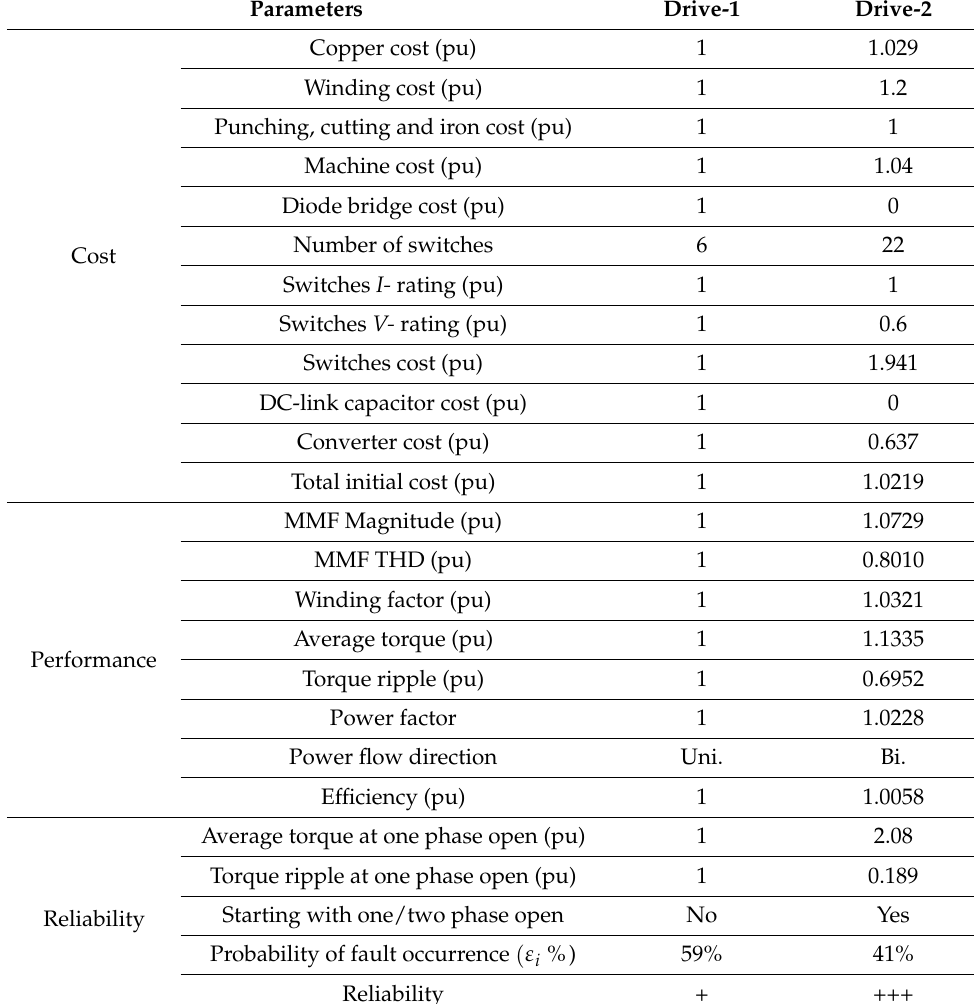
Table 2. Performance, cost, and reliability comparison of the two drive systems [37–39].